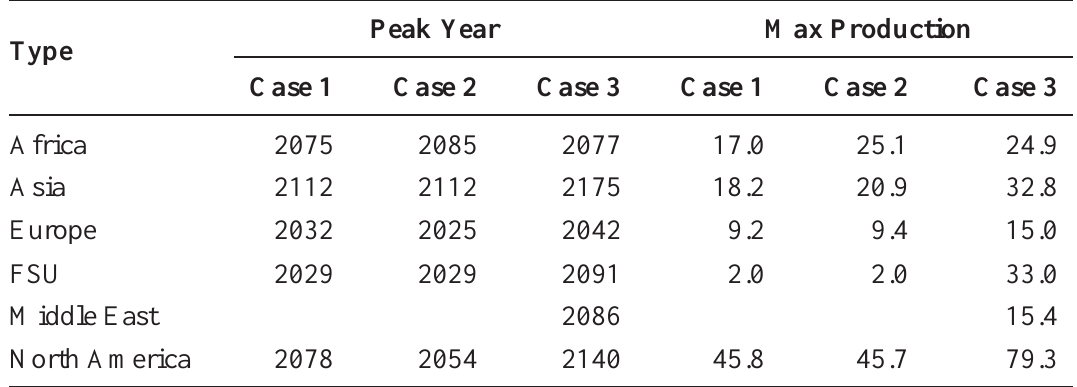
Table 5. Peak years for World by